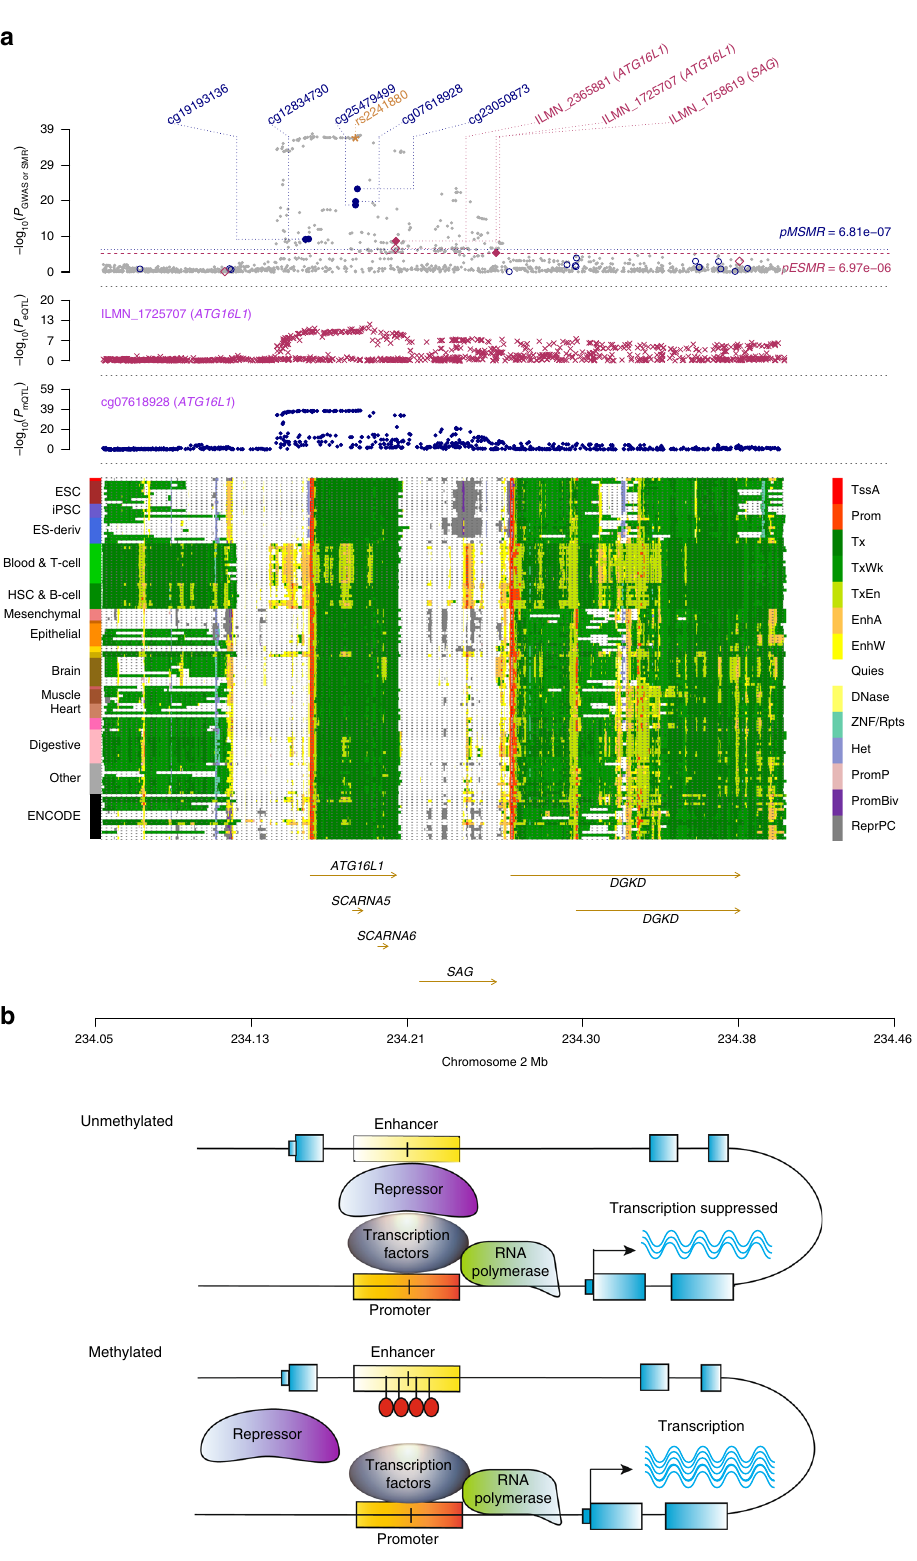
results are across tissues and data sets. We used the same data- fi ltering criteria (Methods) for a replication analysis using eQTL summary data from whole-blood samples in Westra et al. 26 and for a tissue-speci fi c analysis using eQTL summary data from brain samples in the Common Mind Consortium (CMC) 52 ,